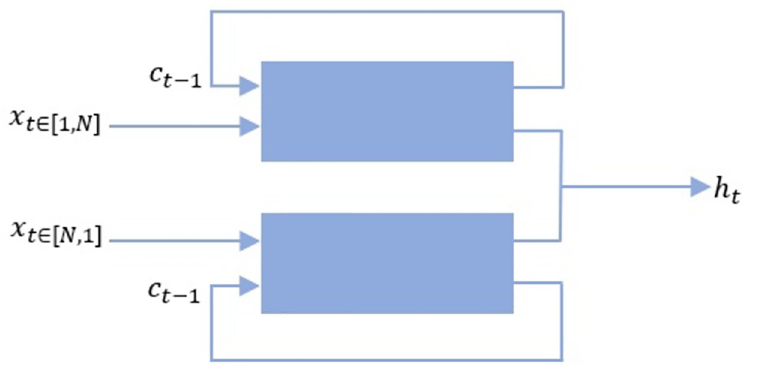
Fig 2. BLSTM cell